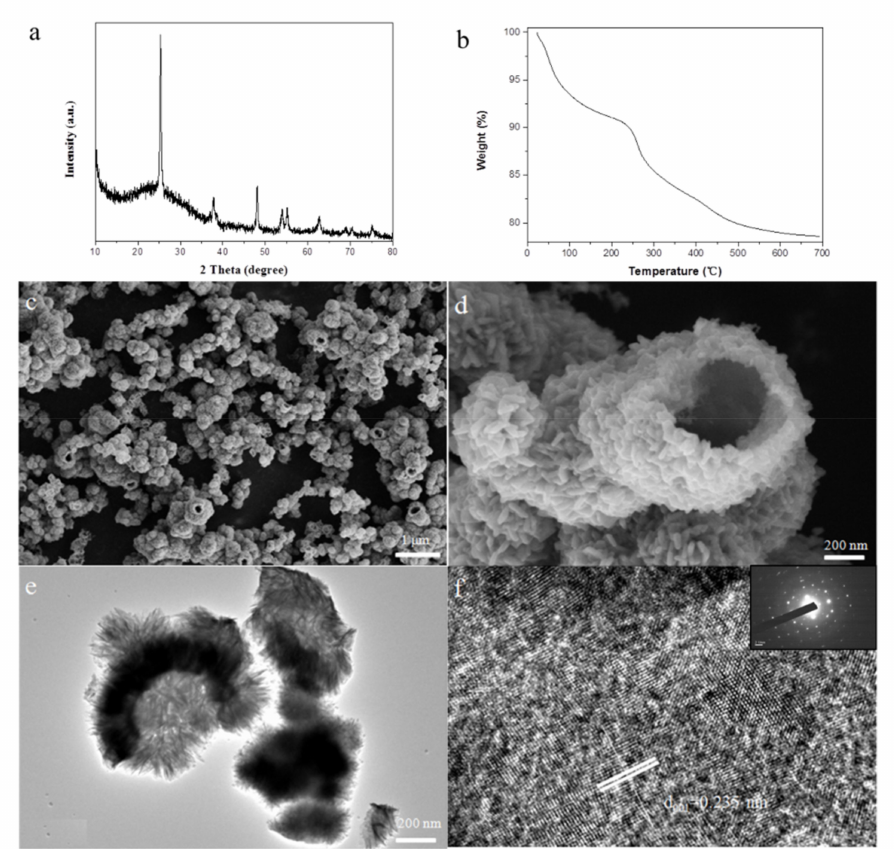
Figure 3. Surface morphology of the TiO 2 after calcination: ( a ) XRD patterns of the samples after calcination; ( b ) TG of the sample after calcination; ( c , d ) SEM images of the sample after calcination; ( e , f ) TEM images of the sample after